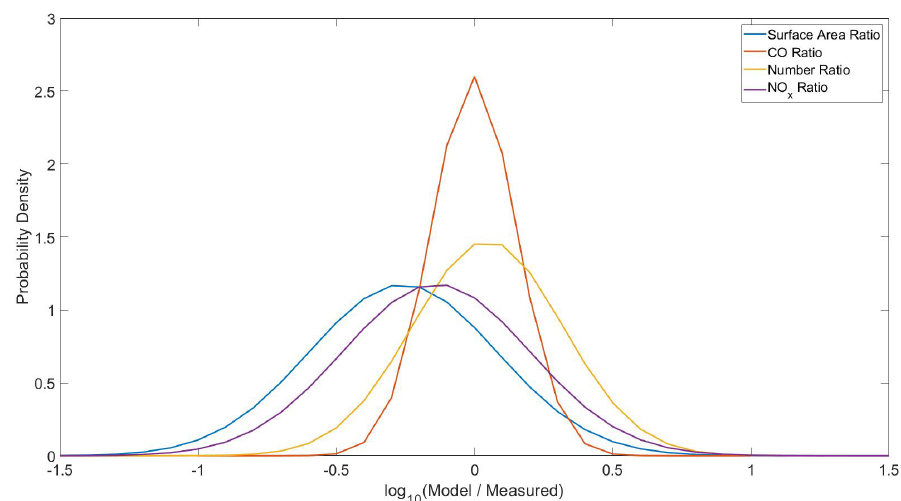
Figure 11. Normalized probability density functions for the log 10 of the model-to-measurement ratio in particle number concentration (yellow), carbon monoxide (red), NO x (purple), and particle surface area concentration